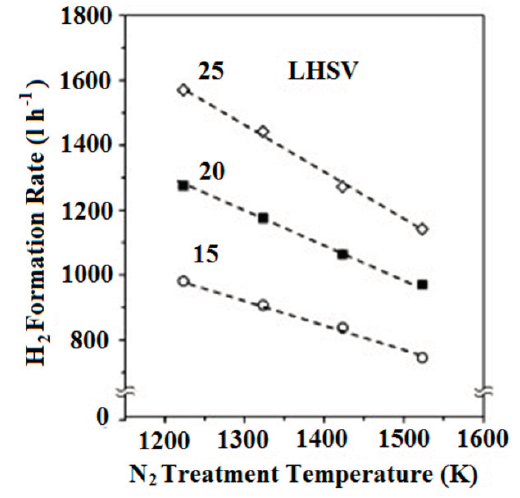
treatment temperature vs. H 2